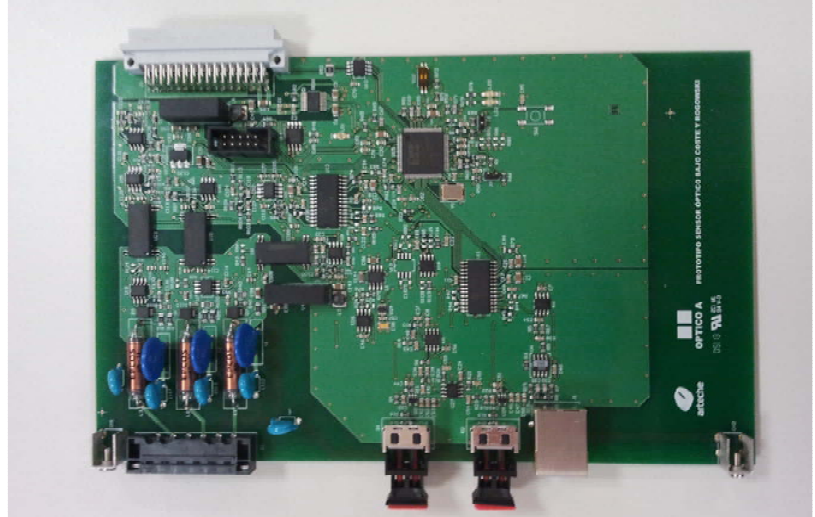
Figure 5. Custom electronic hardware for the acquisition of the current sensor